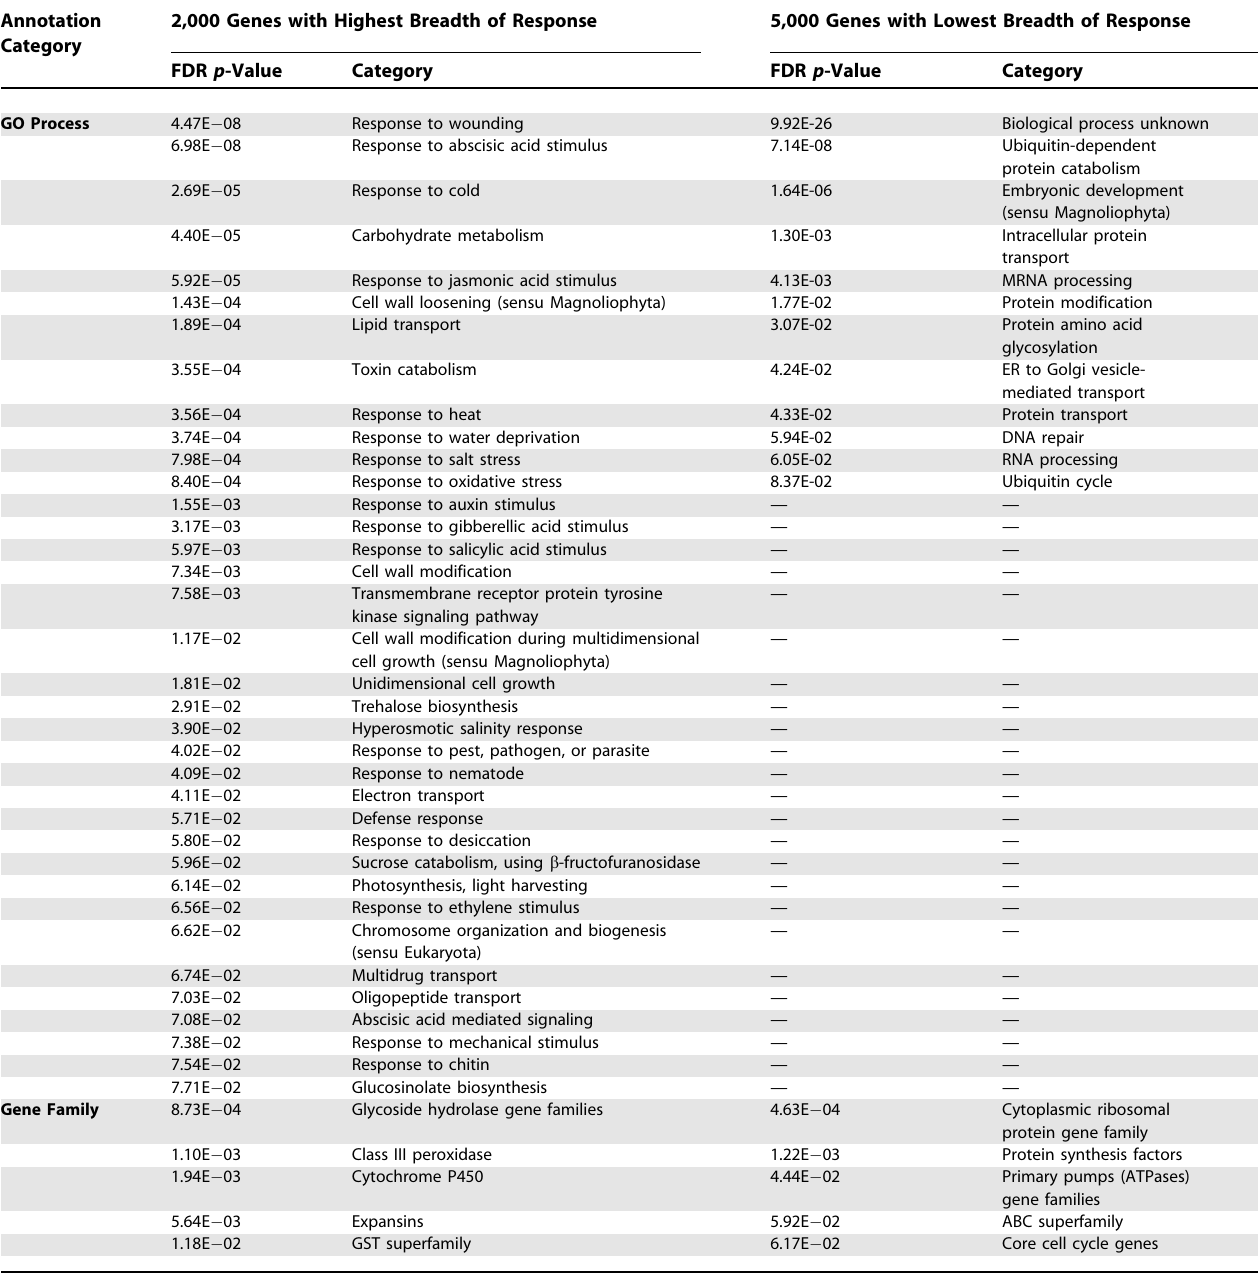
Table 1. Classification of Genes with High or Low Breadth of Differential Gene Expression Response Annotation